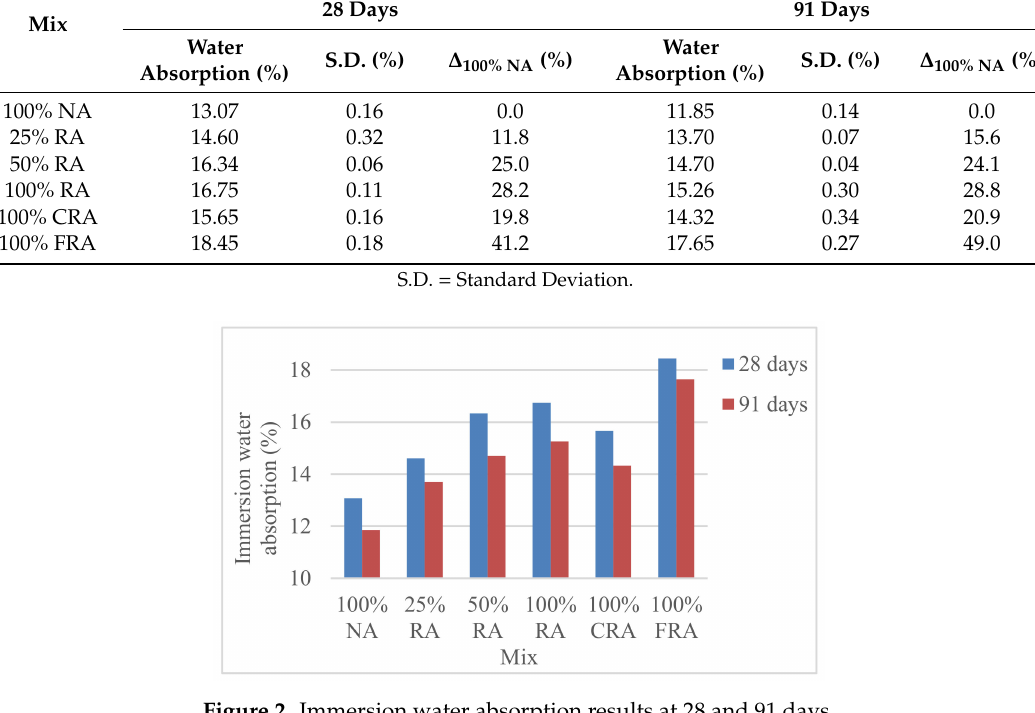
Figure 2. Immersion water absorption results at 28 and 91